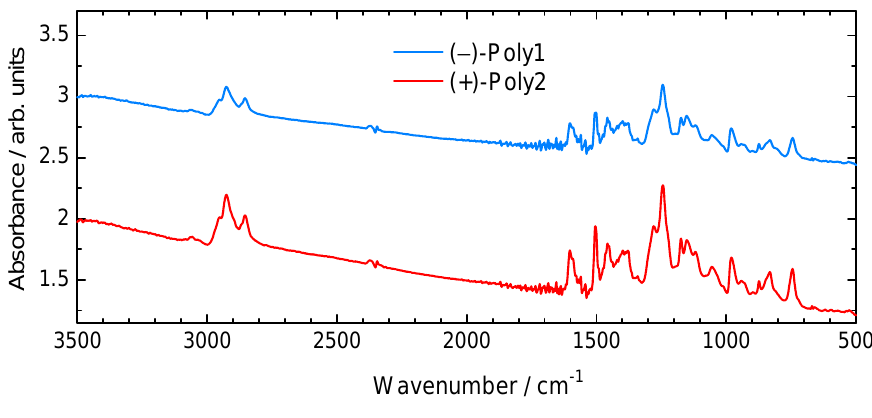
Figure 1. FT-IR spectra of (–)-poly1 and (+)-poly2.